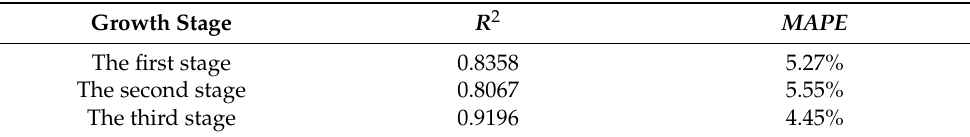
Table 16. R 2 and MAPE for the linear regression plant height